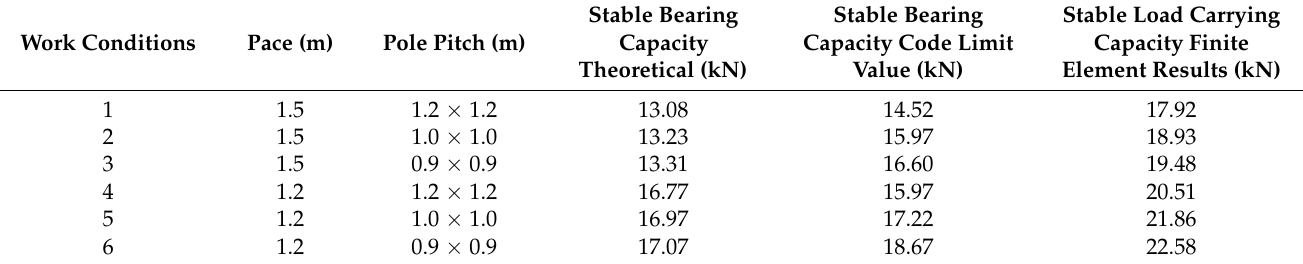
Table 11. Theory, specification, and finite element results of vertical rod stability bearing